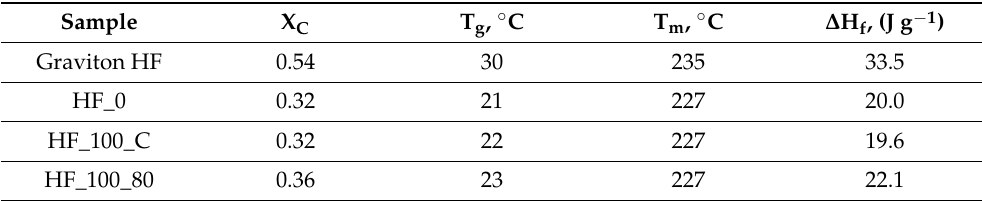
Table 3. DSC analysis results of the PMP HFs samples used in experiments.